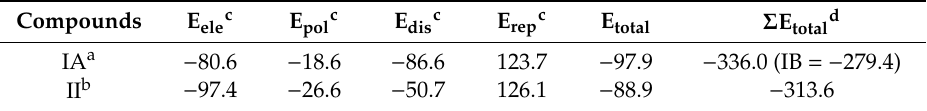
Table 5. Selected interaction energies (kJ mol − 1 ) for I and II .